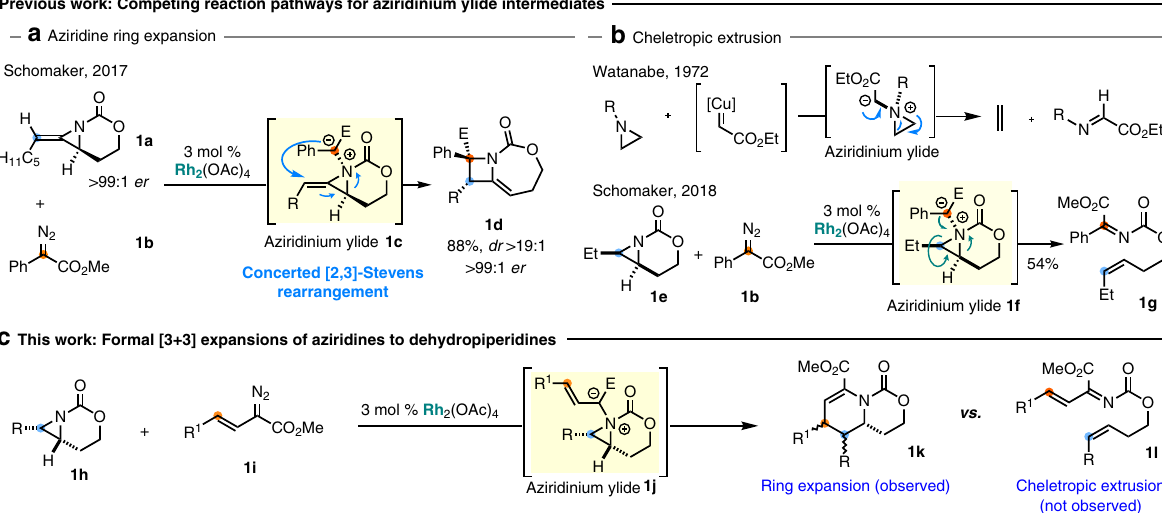
Fig. 2 Reaction design. a Methyleneazetidines from ring expansion of aziridines. b Competing cheletropic extrusion pathways. c Favoring ring expansion over cheletropic extrusion for the synthesis of